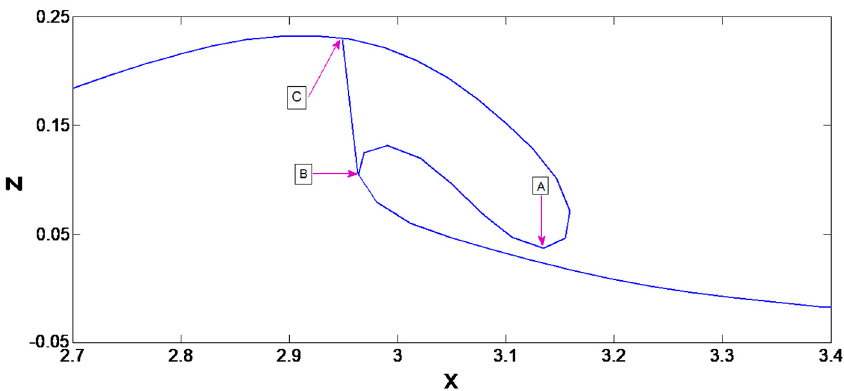
Figure 2. Scheme of the plunging wave cut treatment.